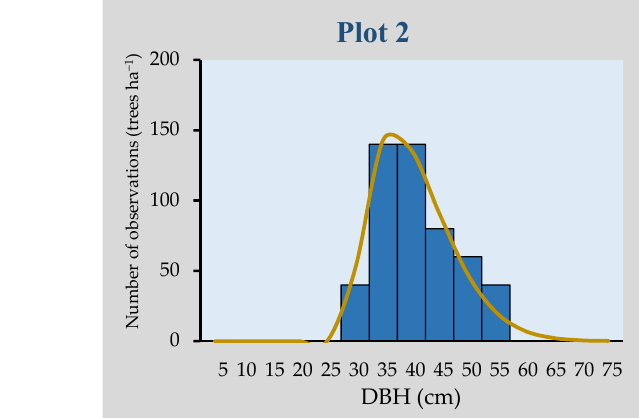
Plot 3 Plot 4 Figure 3. Cont